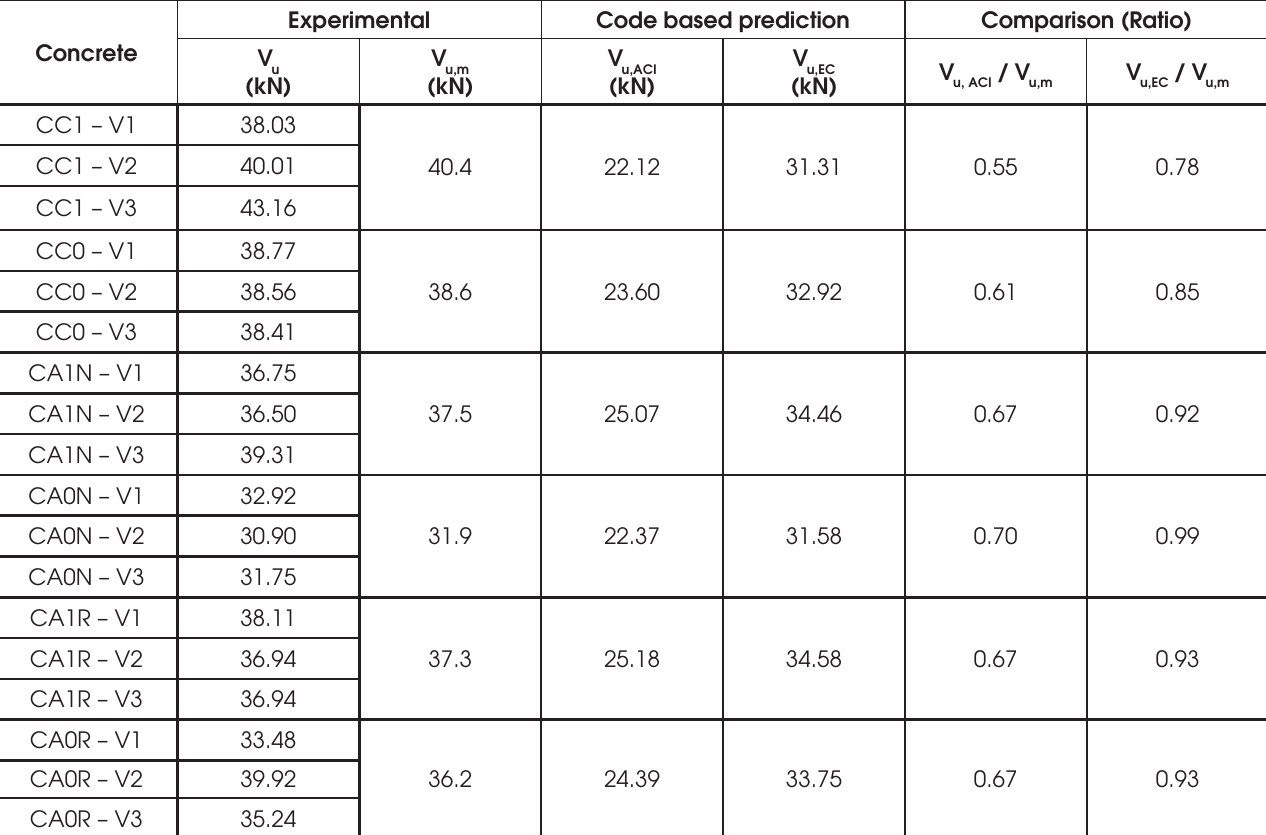
Ultimate shear load form experiments, code based prediction and these values ratio Experimental Code based prediction Comparison Concrete